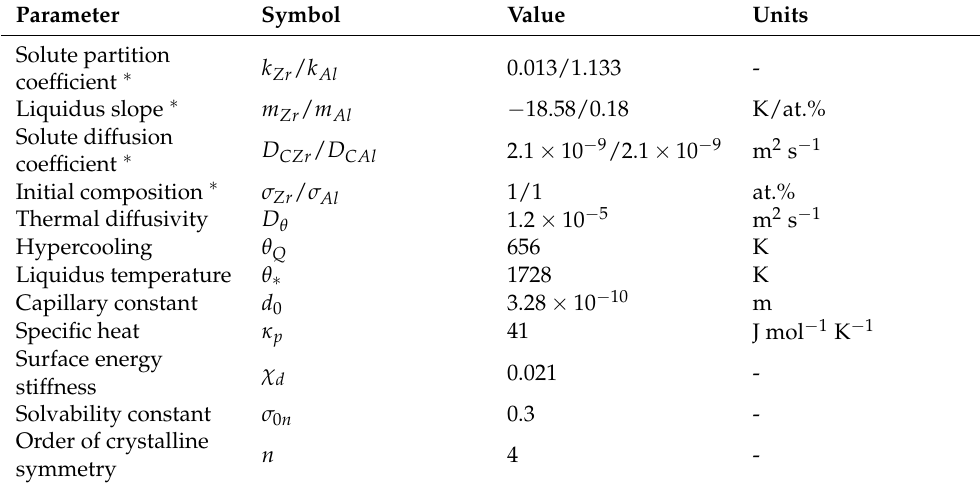
Material and calculation parameters for the alloy Ni 98 Zr 1 Al 1 . Subscripts Zr and Al correspond to subscripts 1 and 2 in formulas (lines marked by ∗